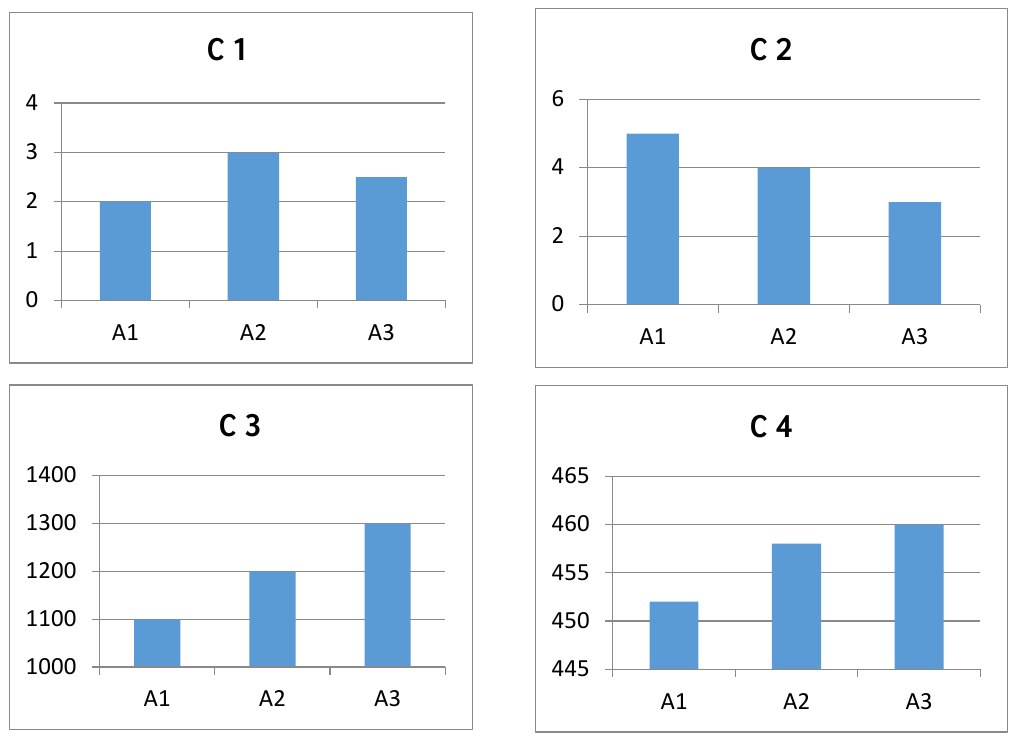
Fig. 1. A comparison of alternatives in terms of different criteria.